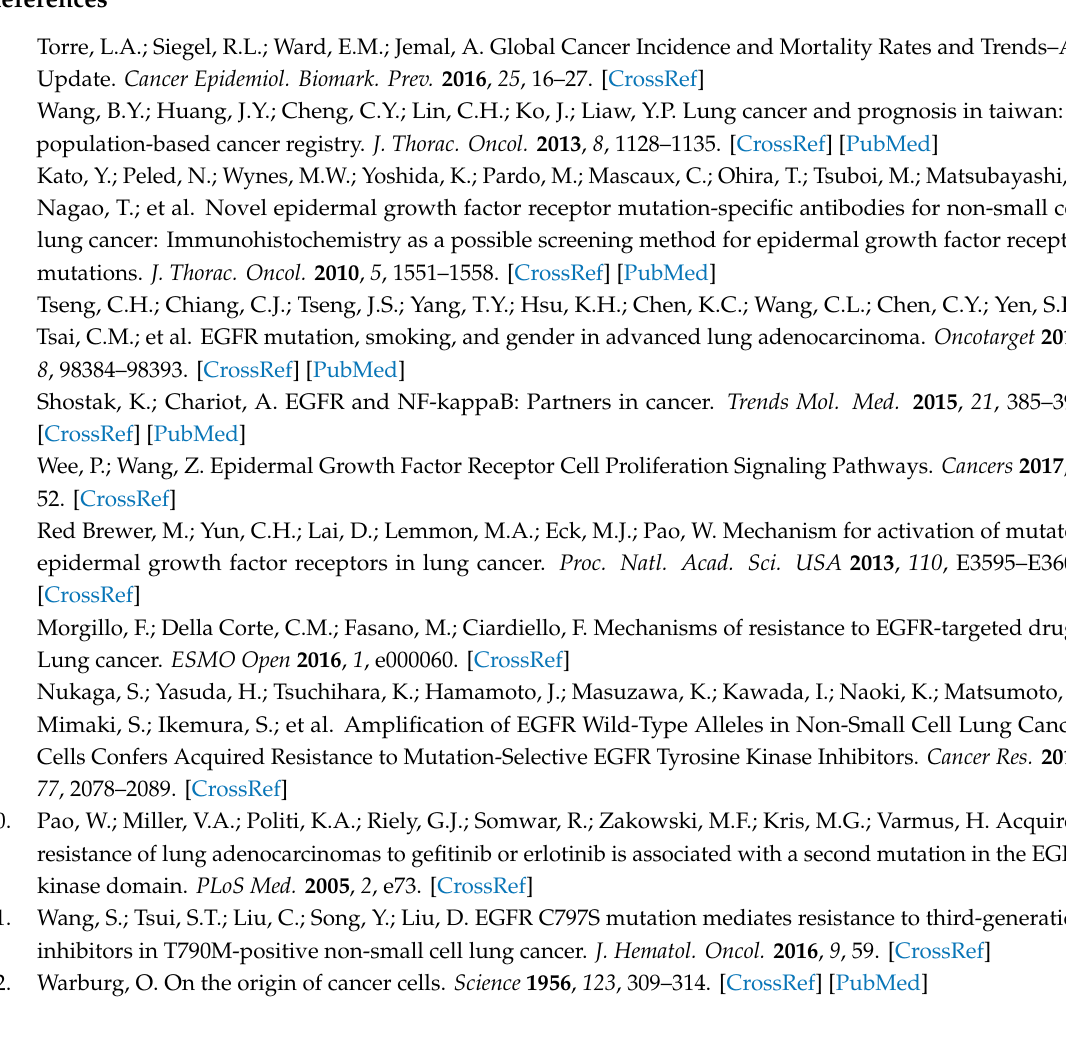
Figure S1: A schema of the cellular bioenergetics parameters assessed by the XF24 extracellular flux analyzer, Figure S2: Index of mitochondrial complex activity. The schematic illustration represents the measurement of mitochondrial complex activity by Seahorse XF24